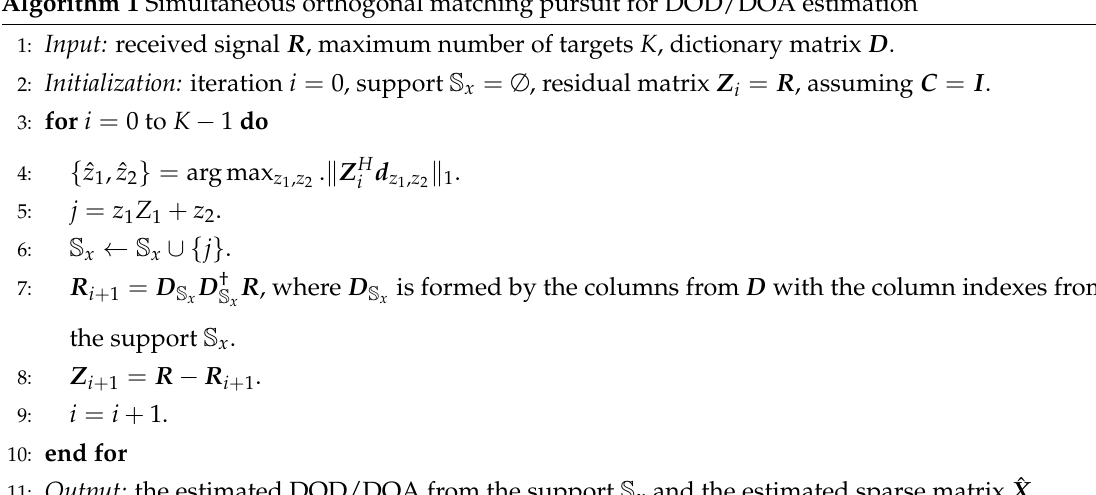
Algorithm 1 Simultaneous orthogonal matching pursuit for DOD/DOA